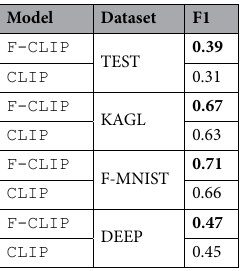
Table 2. Comparing the performance of FashionCLIP ( F-CLIP ) on product classification task over several datasets ( F1 is weighted macro F1 ). Best performing models are in bold.